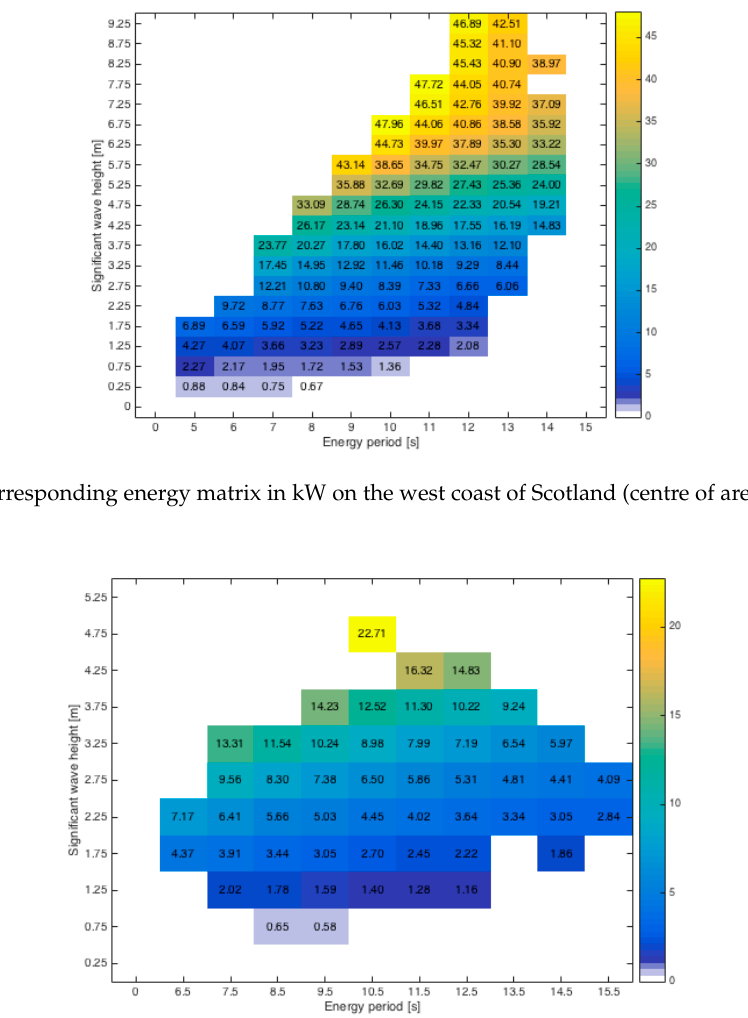
Figure 7. Scatter diagram of sea states on the west coast of Scotland (centre of area is at 57° N, 9° W). Numbers indicates occurrence in hours per year.